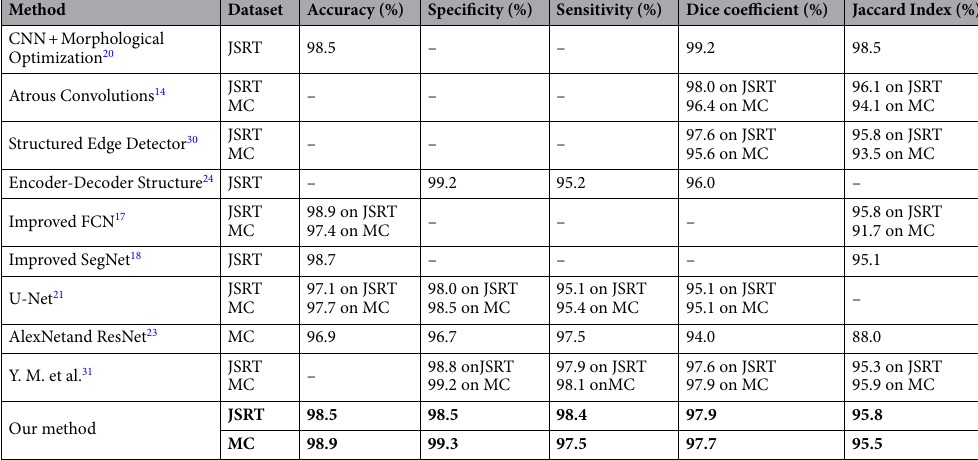
Table 6. Comparison of results of the proposed method and recently related works. Significant values are in